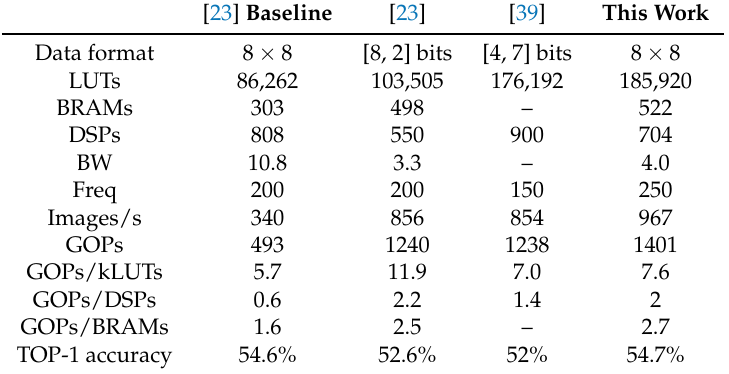
Table 4. Performance comparison of the proposed architecture with previous works running AlexNet in ZYNQ7045